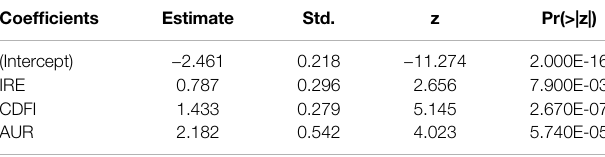
TABLE 5 | Results of the logistic regression analysis to determine the association between ultrasound characteristics and FTC malignancy. Coef fi cients Estimate Std.